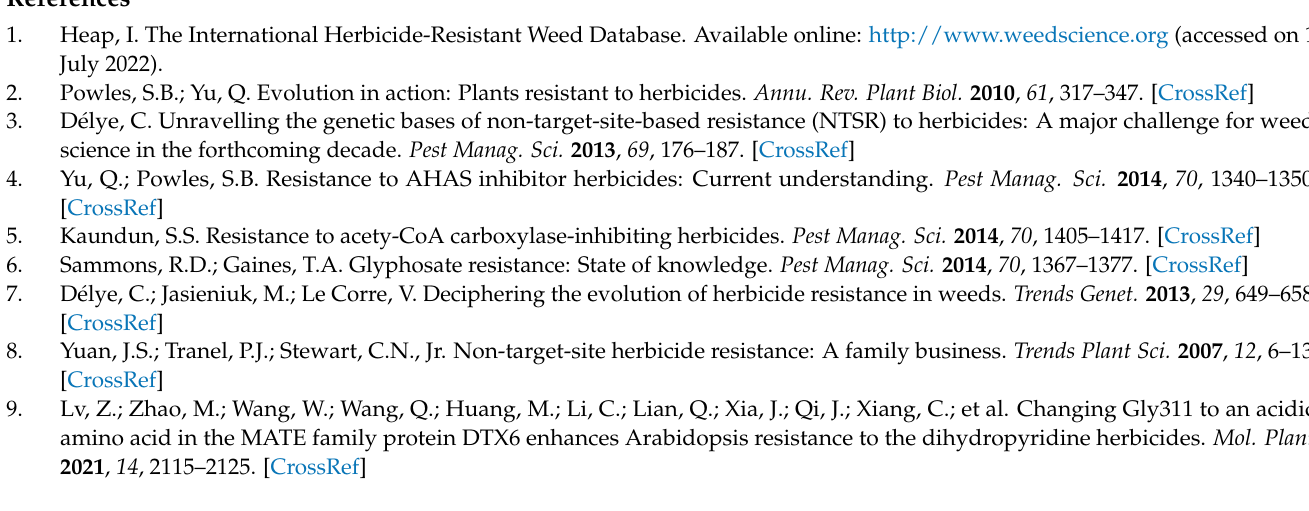
Table S2: Transcriptional splicing data statistics; Table S3: Primers for fluorescent quantitative of Eleusine indica (L.)